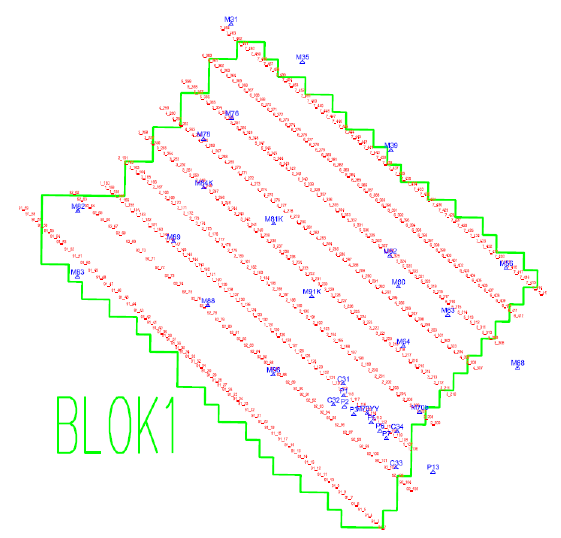
Fig 3. The position of Ground Control Points in the Test